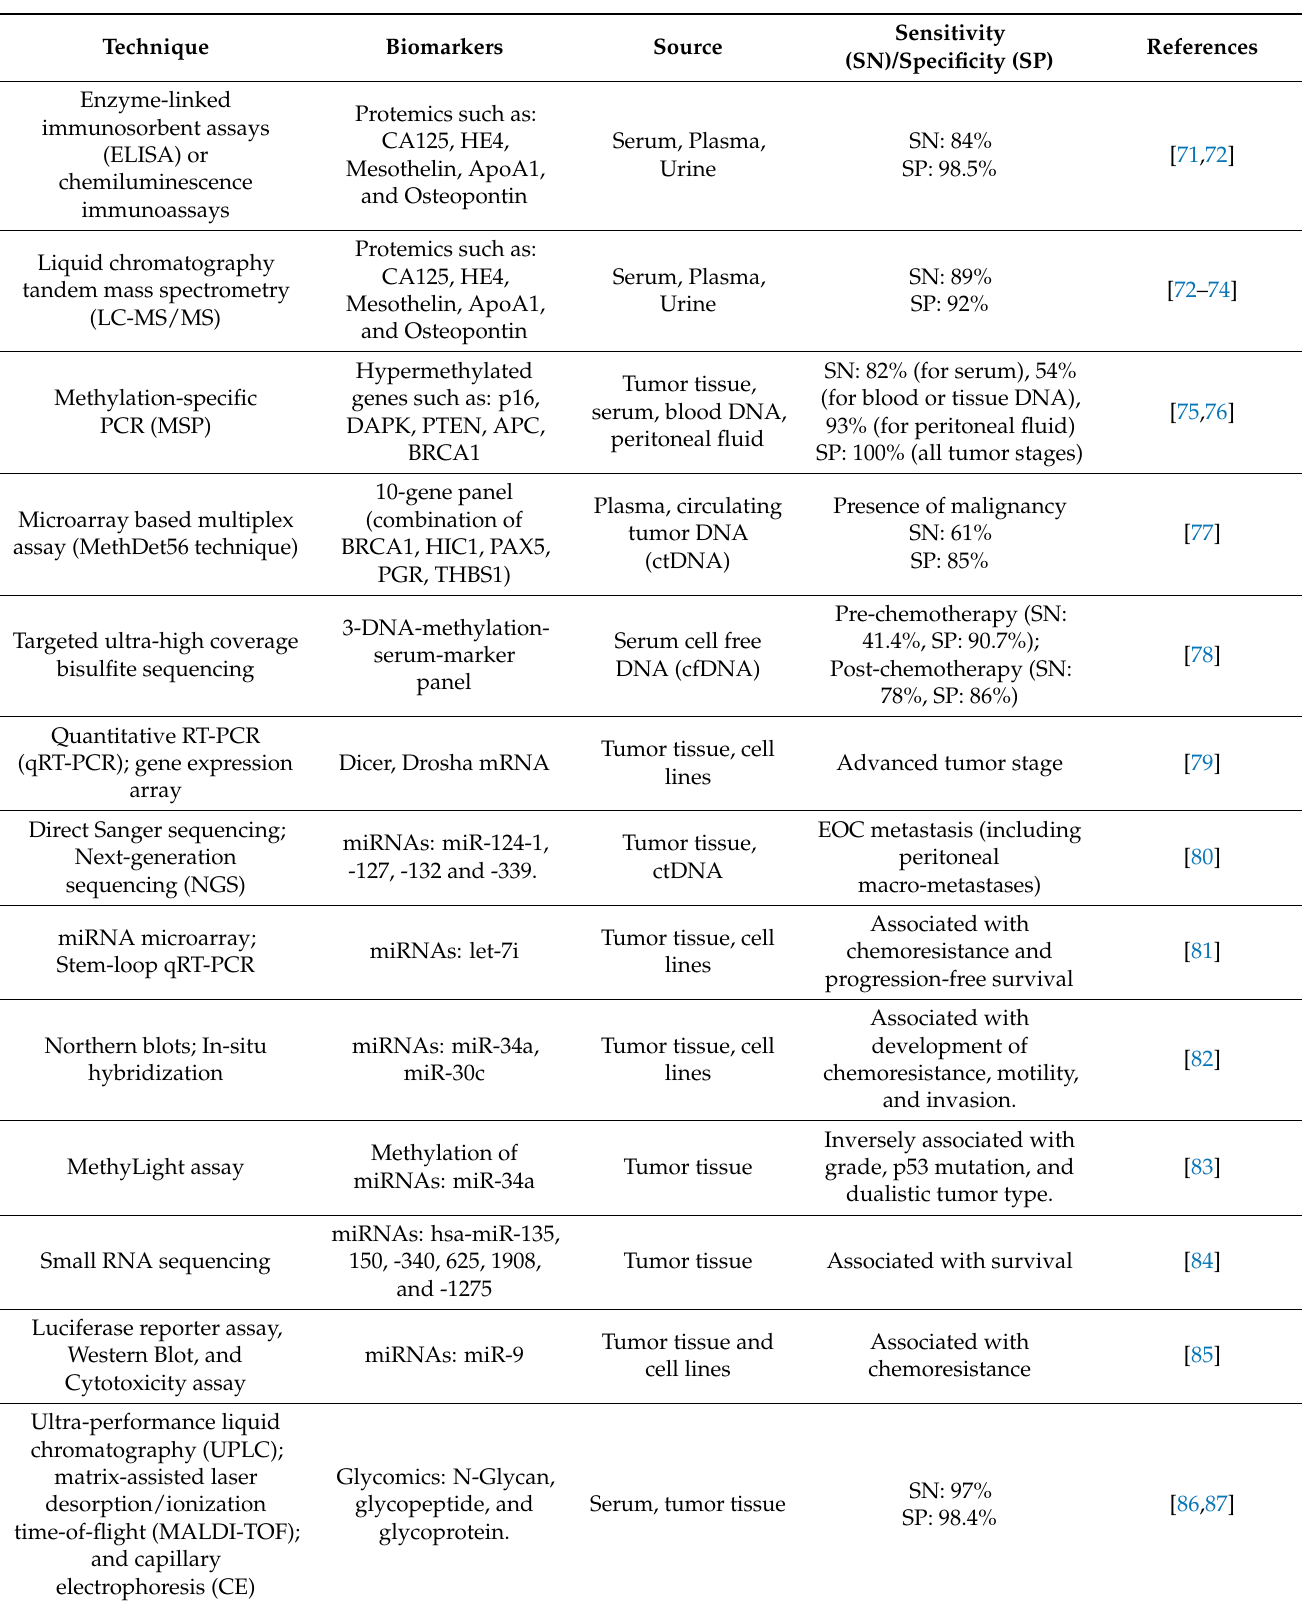
Table 1. List of selective techniques and biomarkers for EOC